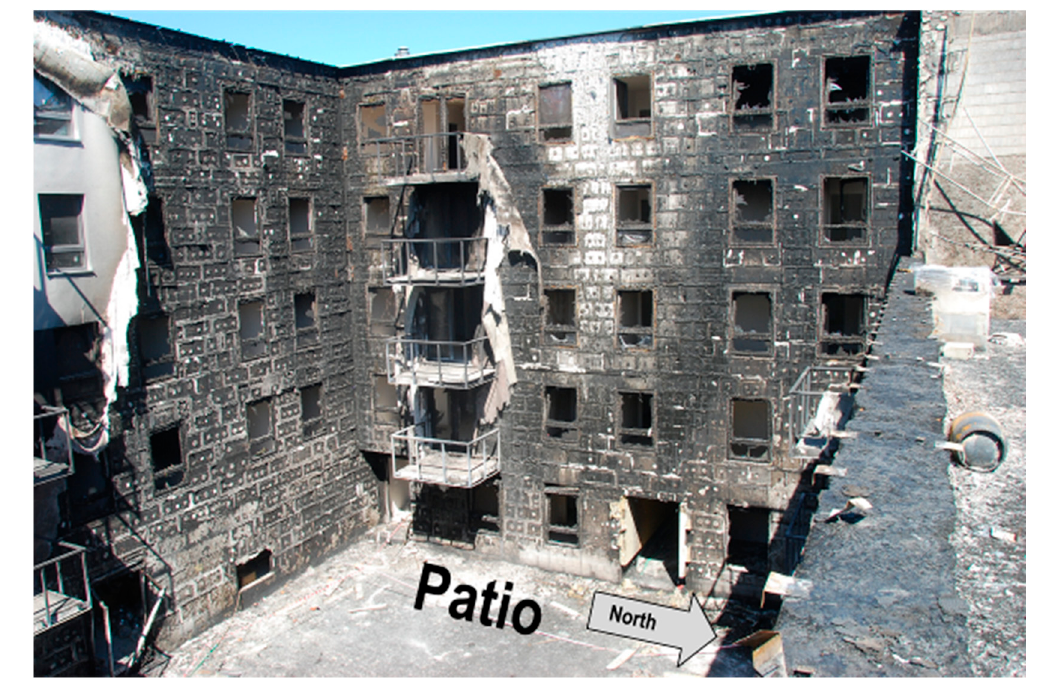
Figure 5. Façades after the fire.